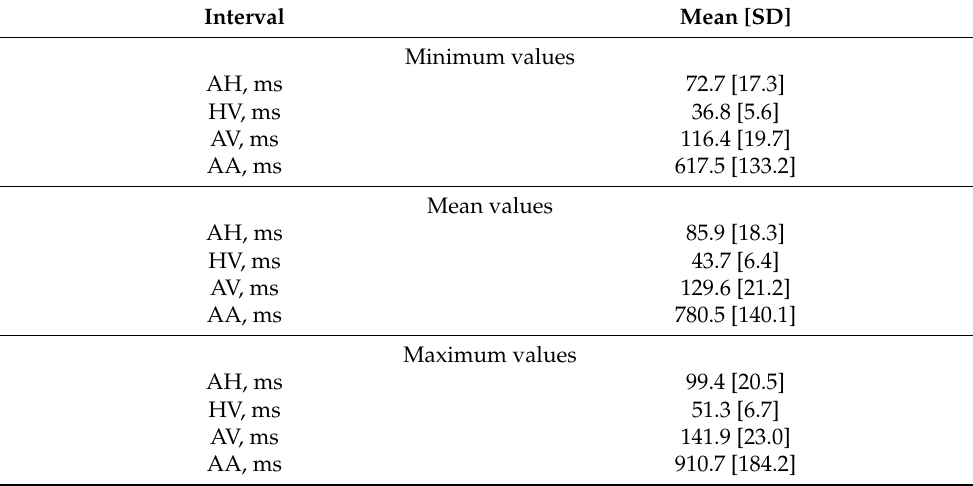
Table 2. Summary of the duration of AH, HV, AV, and AA intervals in the whole study group.